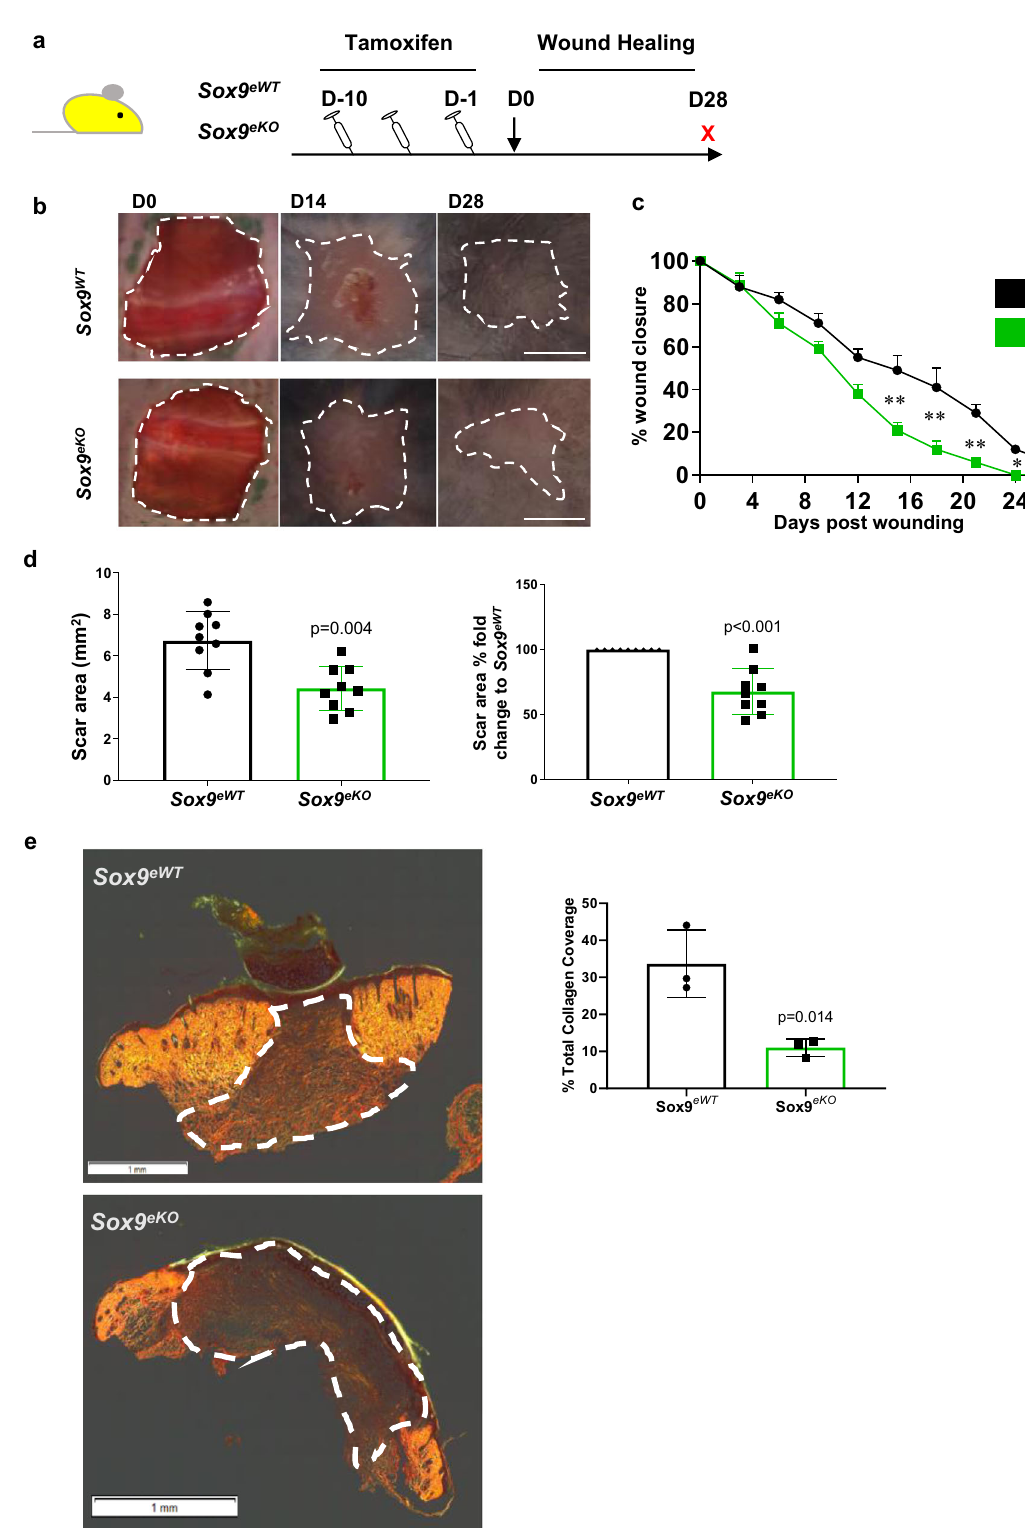
Fig. 3 Loss of Sox9 in the endothelium signi fi cantly impairs EndMT and reduces scarring during wound healing. a Schematic diagram demonstrating experimental set up using conditional vascular speci fi c Sox9 knockout mice ( Sox9 fl / fl /Cdh5-Cre ER RosaYFP – Sox9 eKO ). b Digital photography images showing macroscopic wound healing over the course of 28 days (D28) post wounding between wild-type controls ( Sox9 eWT ) and Sox9 eKO . Scale bar = 5mm. c Skin wound healing rate as a percentage of initial wounded area was signi fi cantly increased in Sox9 eKO compared to Sox9 eWT (* p <0.05; ** p <0.01 vs Sox9 eWT ; n = 8 biologically independent animals; mean±SD; p value was calculated by two-tailed unpaired t test). d After 28 days, a signi fi cant decrease in macroscopic scar area was observed in Sox9 eKO mice compared to Sox9 eWT (p = 0.004; n = 8 biologically independent animals; mean ± SD; p value was calculated by two-tailed unpaired t test) e Sirius red collagen staining of both 6mm and large wounds demonstrates a signi fi cant decrease in total collage coverage within the granulation tissue in Sox9 eKO compared to Sox9 eWT ( p = 0.0014 vs Sox9 eWT ; n = 3 biologically independent animals; mean±SD; p value was calculated by two-tailed unpaired t